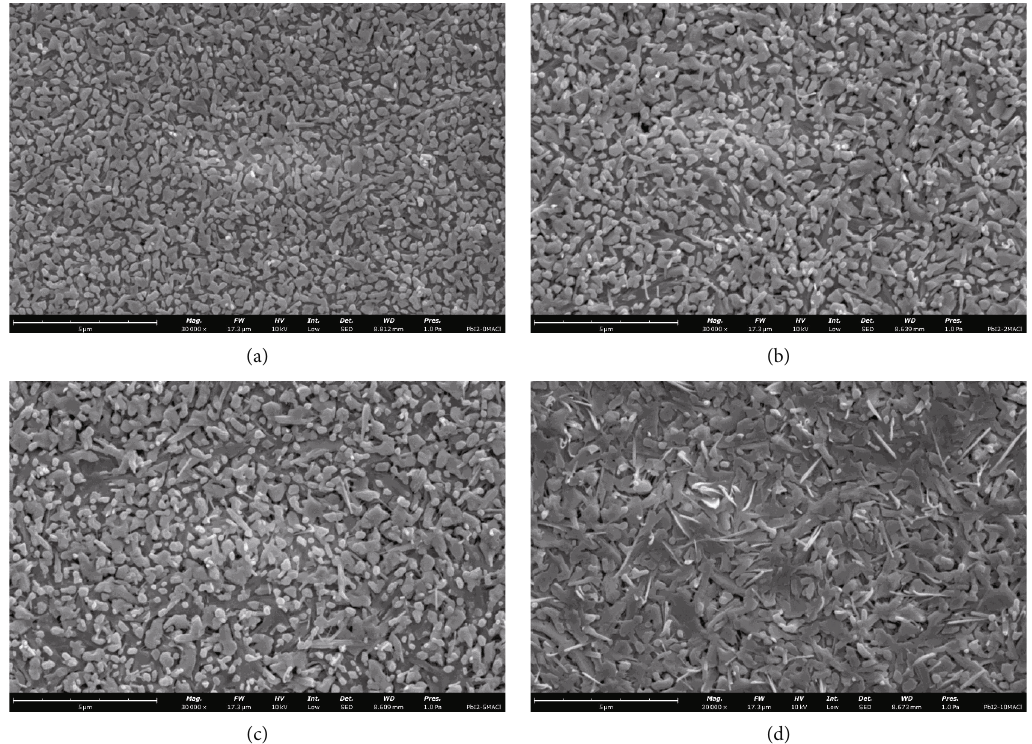
fi lms added di ff erent concentrations of MACl: (a) without MACl; (b) with 2 g/L MACl; (c) with Figure 1: The surface SEM images of PbI 2 5g/L MACl; (d) with 10g/L MACl (scale: 5 μ